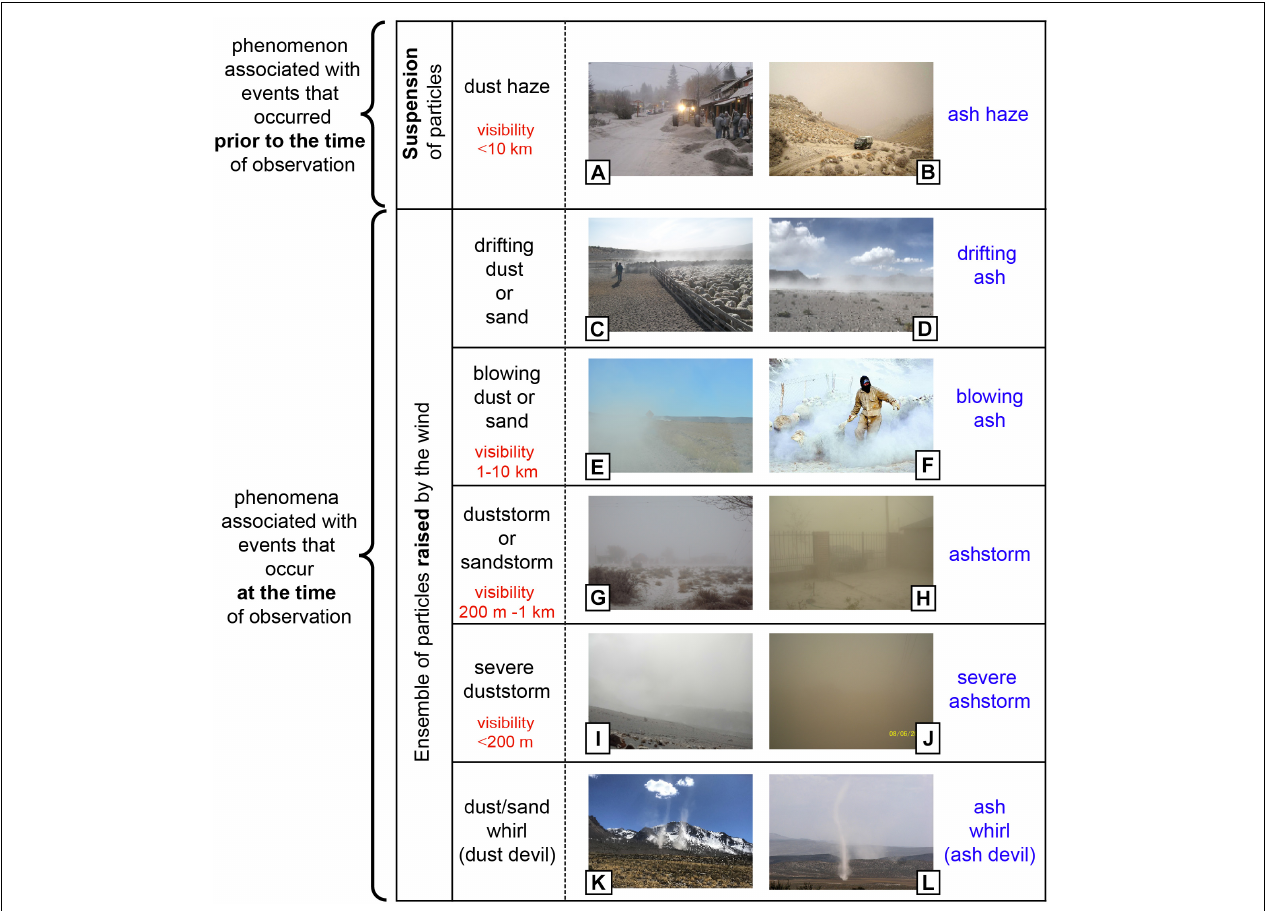
FIGURE 1 | Correspondence between wind-remobilisation of volcanic ash (right column) and the WMO classification for lithometeors (left column). Also see Table 1 for further details. (A–C,E–H,J,L) Photographs taken in or nearby Ingeniero Jacobacci (Argentina), 230 km from the CC vent. (D,I,K) Photographs taken around Sabancaya volcano (Peru), about 5 km from the vent. Source of photographs: A,B,G,H , Radio Nacional de Jacobacci LRA54; C,F , Jazmin Miguel; D,E,K , Lucia Dominguez; I , Paul A. Jarvis; J , Gonzalo Pozos; L , Donaldo